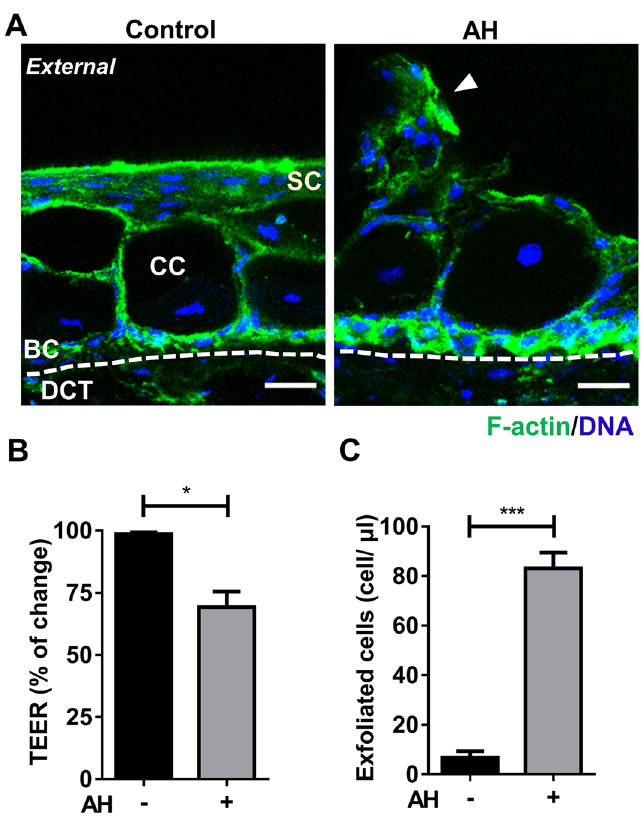
Figure 6. Epidermis cell damage in response to AH inoculation in the skin model. AH was inoculated into the ventral skin model and incubated for 6 h. ( A ) Tissue sections of skin model were stained for F-actin (green) and DNA stain (blue). Sections showing the superficial epithelial cells (SC), basal epithelial cells (BC), dense collagenous tissue (DCT), club cells (CC). The dissociated epithelial cells at surface epithelium was observed (arrowhead). Shown are representative images, Bar = 10 μm. ( B ) The transepithelial electrical resistance (TEER) was measured and percentage change was compared to TEER at 0 h. ( C ) Exfoliated cells in the apical chamber were counted using light microscopy. All data were shown as mean values (± SEM). Four fish and three replicates of tissue were used. Statistical significance was determined by using Student’s t-test. *p ≤ 0.05 ***p ≤ 0.001; **p ≤